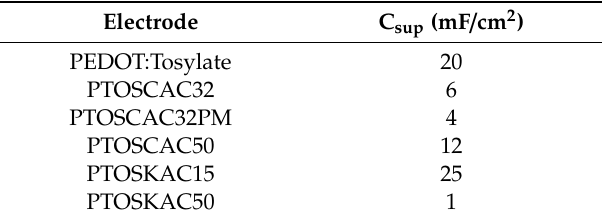
Table 3. Characteristics of electrode–electrolyte systems prepared. Electrode